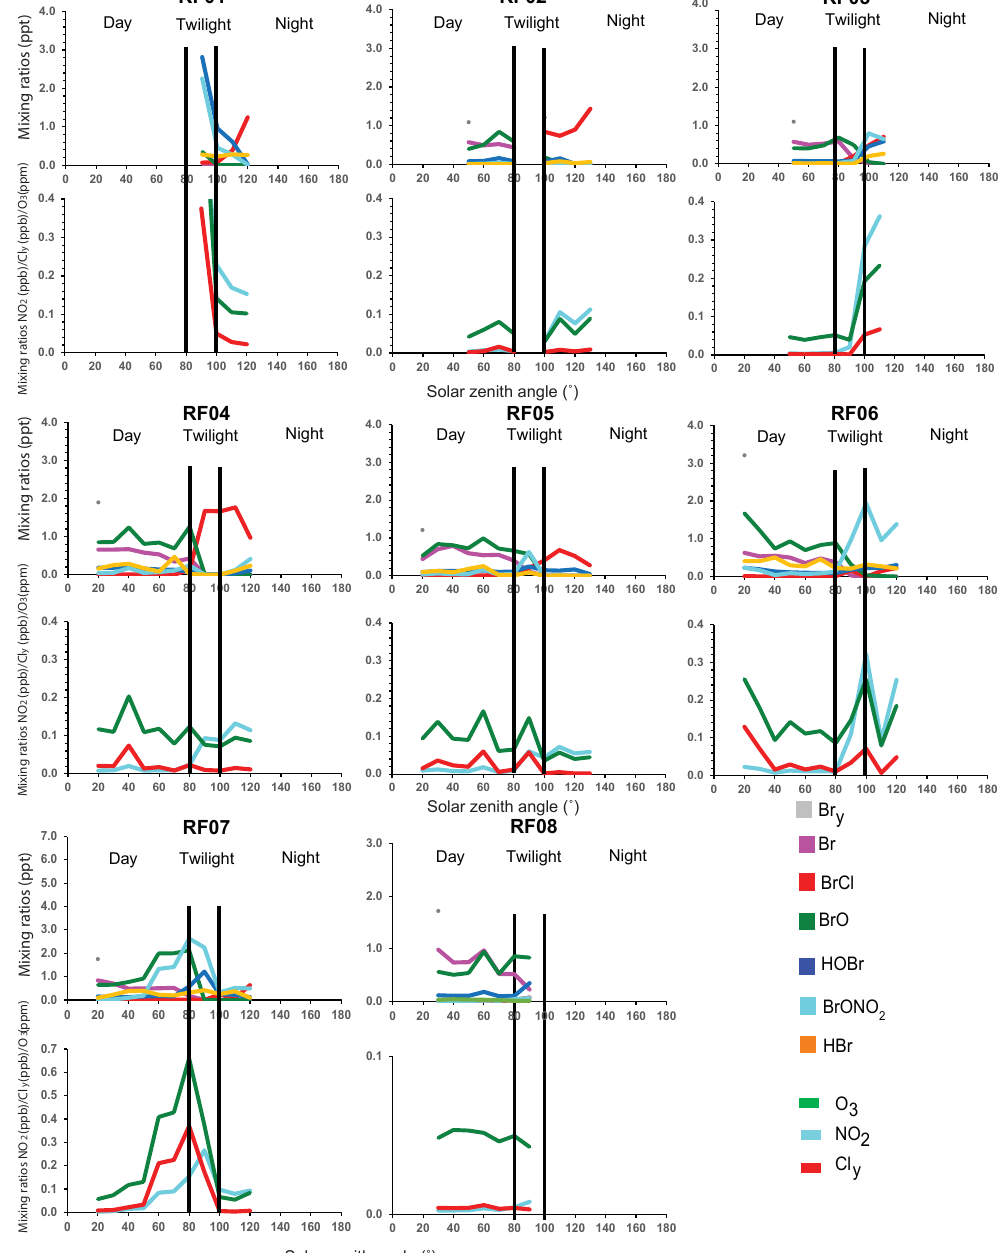
Figure 5. Inorganic bromine species and main reactants of the inorganic chemistry sampled at exactly the same times and locations as the ATTREX flights developed over the western Pacific. Each separated panel shows SZA dependent results for flights RF01, RF03, RF04, RF05, RF06, RF07 and RF08. The black vertical lines represent twilight hours. Only output sampled between 14 and 18km is